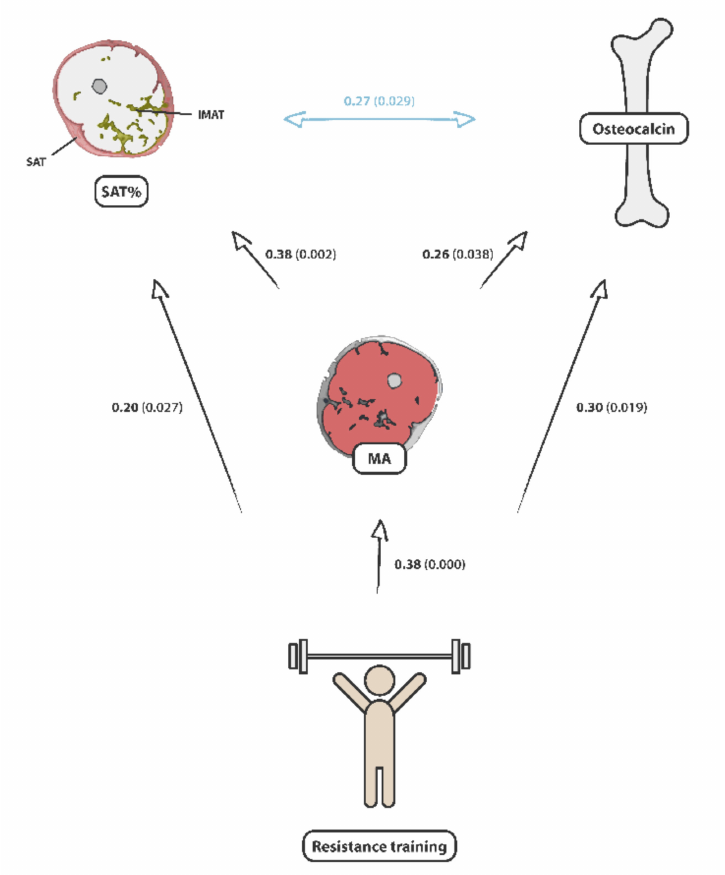
Figure 3. Overview of the interrelationships between SAT/(SAT + IMAT), cross-sectional muscle area, serum osteocalcin, and resistance training. The strength of the relationships is given by Pearson’s correlation coefficients and the corresponding p -values (cc ( p